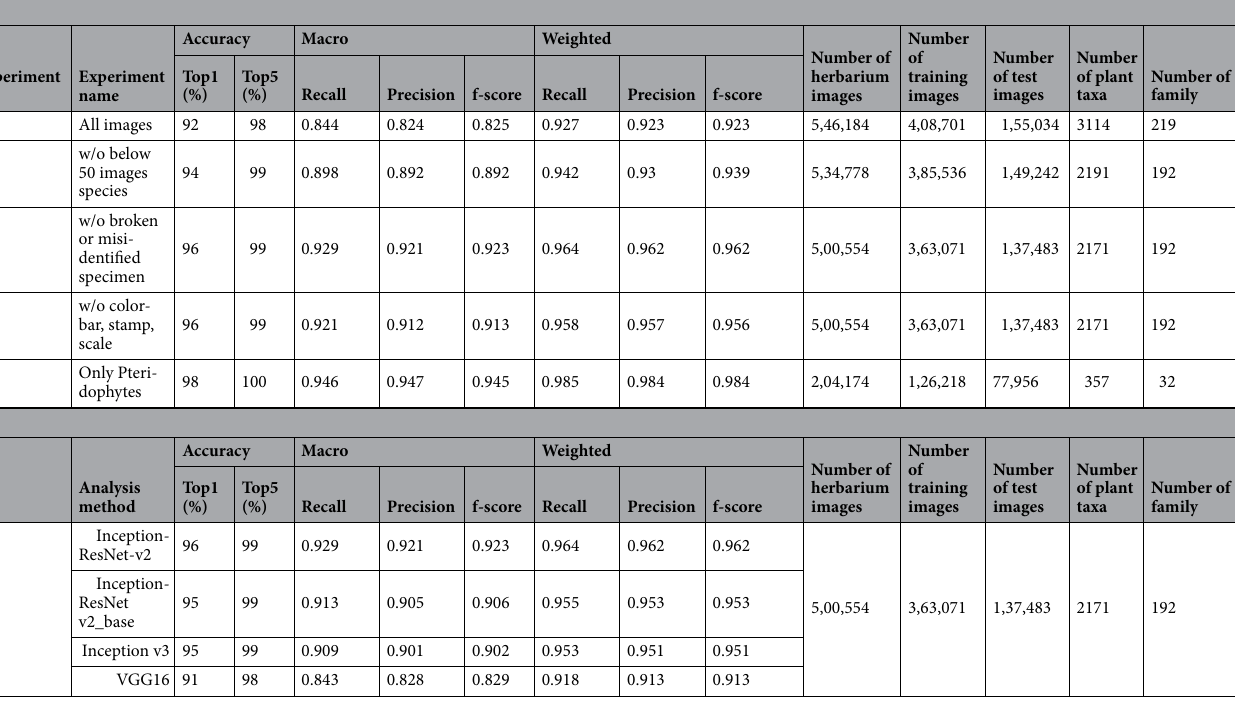
Table 1. (a) List of experiments and results. (b) List of methods and results. These experiments were performed with the specimens used for the third experiment (excluding broken and misidentified